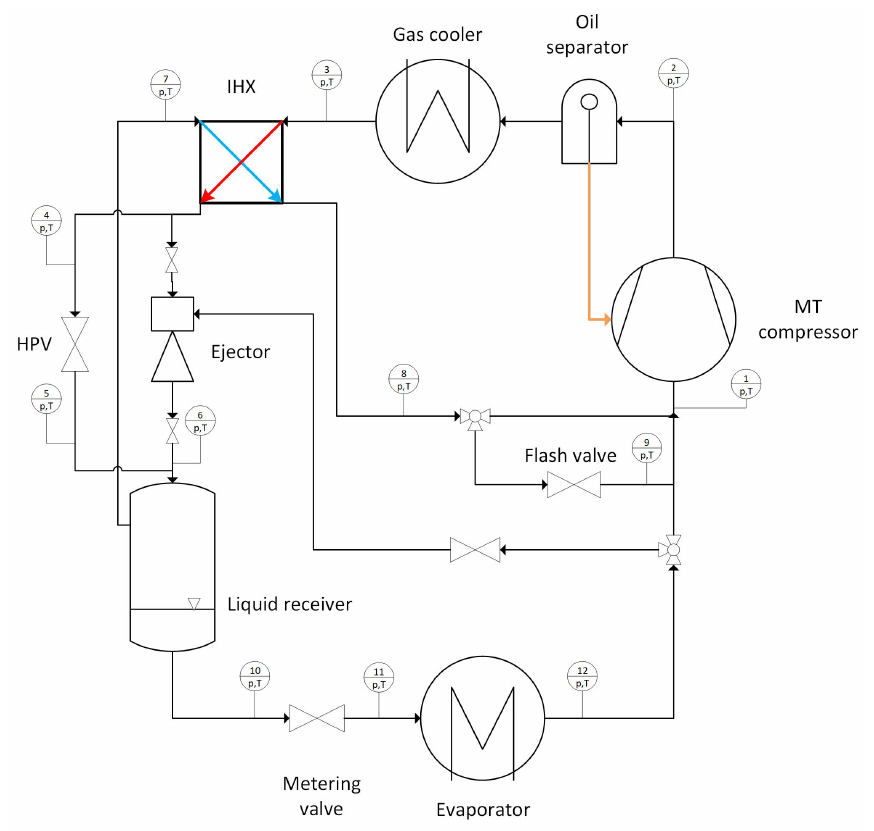
Figure 3. The P & ID diagram of the R744 transcritical cycle equipped with the two-phase